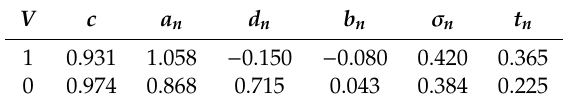
Table 4. Parameters of prior density and likelihood function in the transformed space.